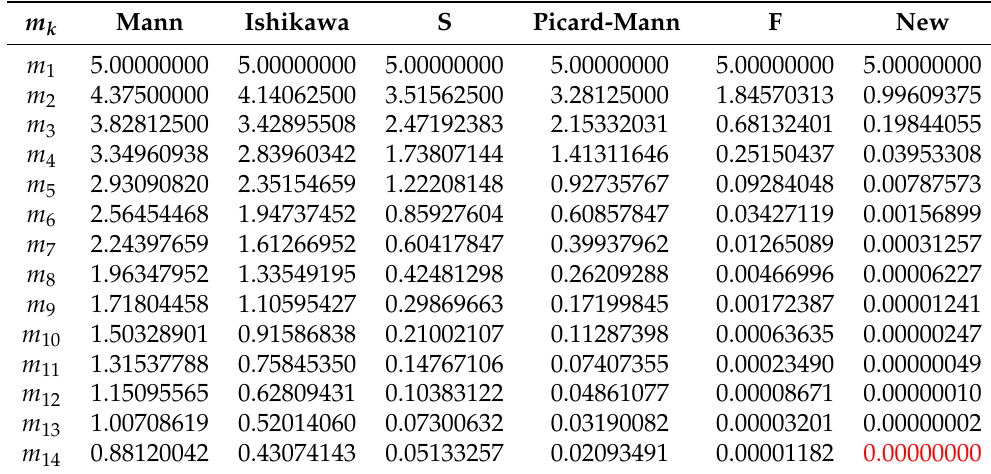
The reds show the point of convergence of various iterative methods. Table 4. Convergence behavior of various iterative